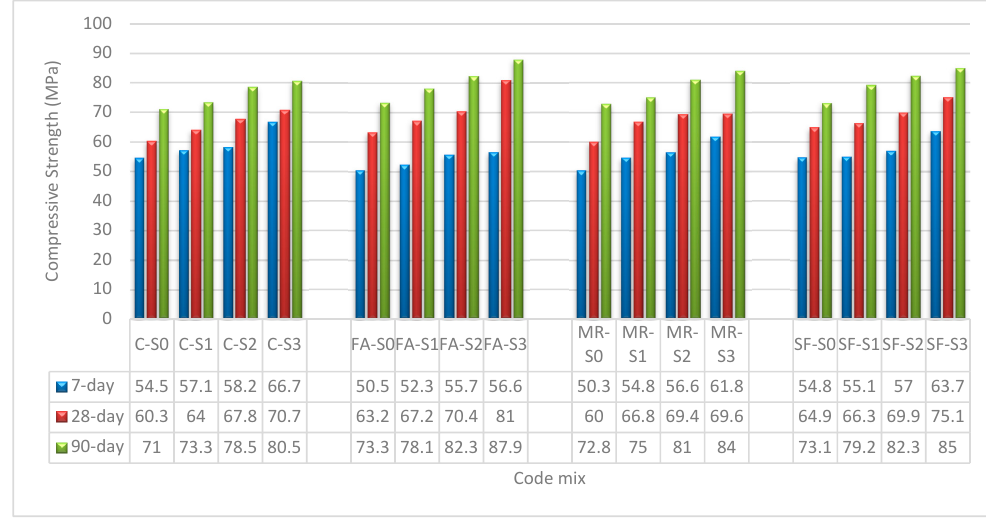
Figure 5. Compressive strength test at 7, 28, and 90 days.